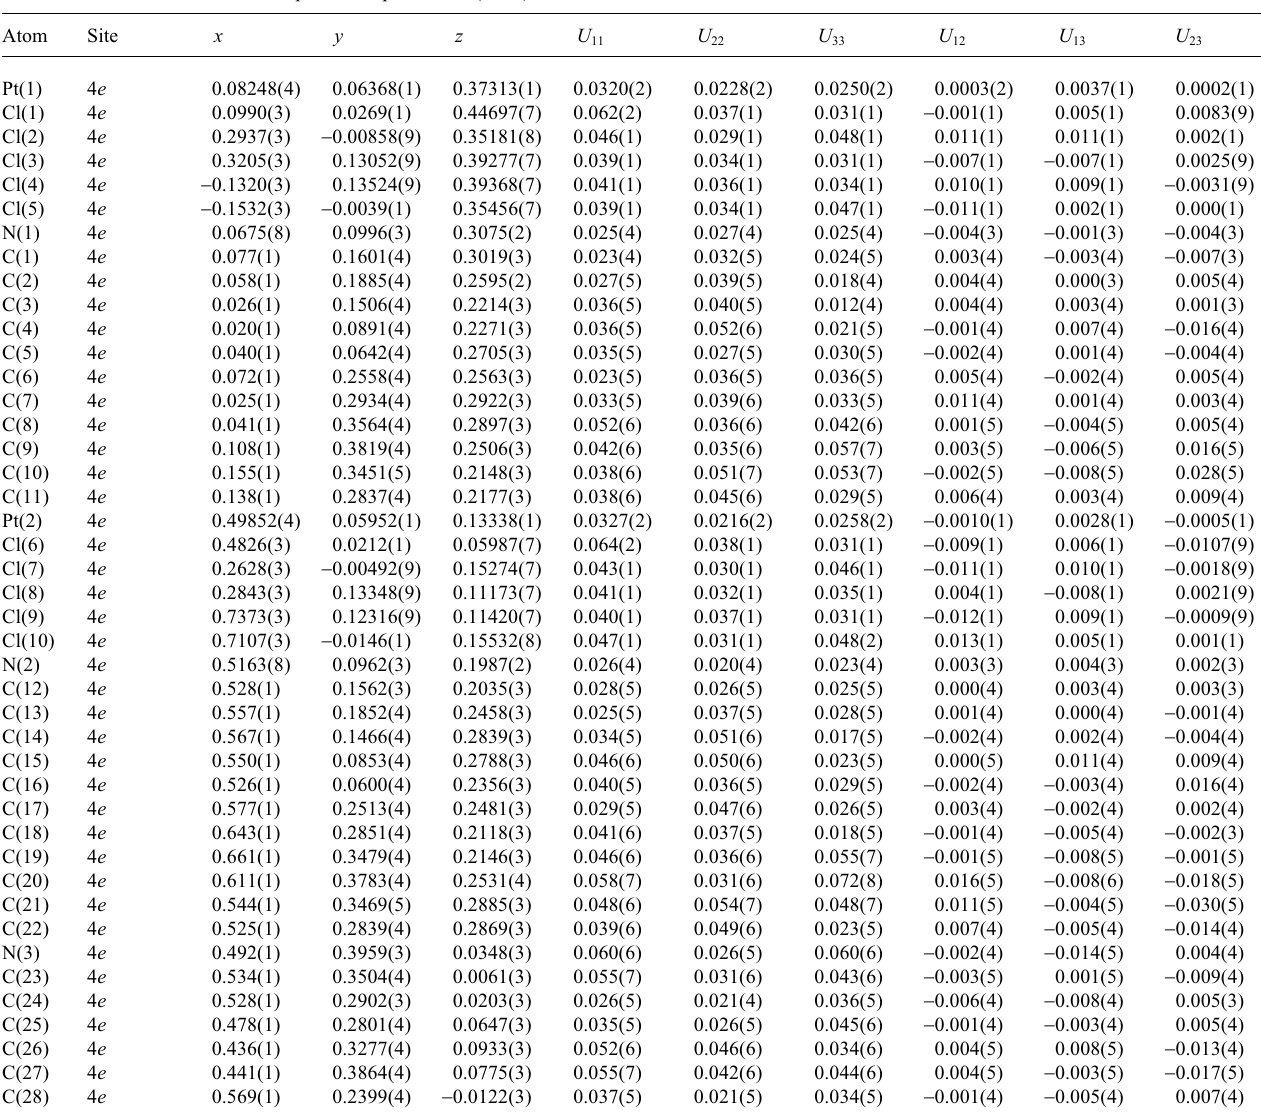
Table 3. Atomic coordinates and displacement parameters (in Å 2 ).